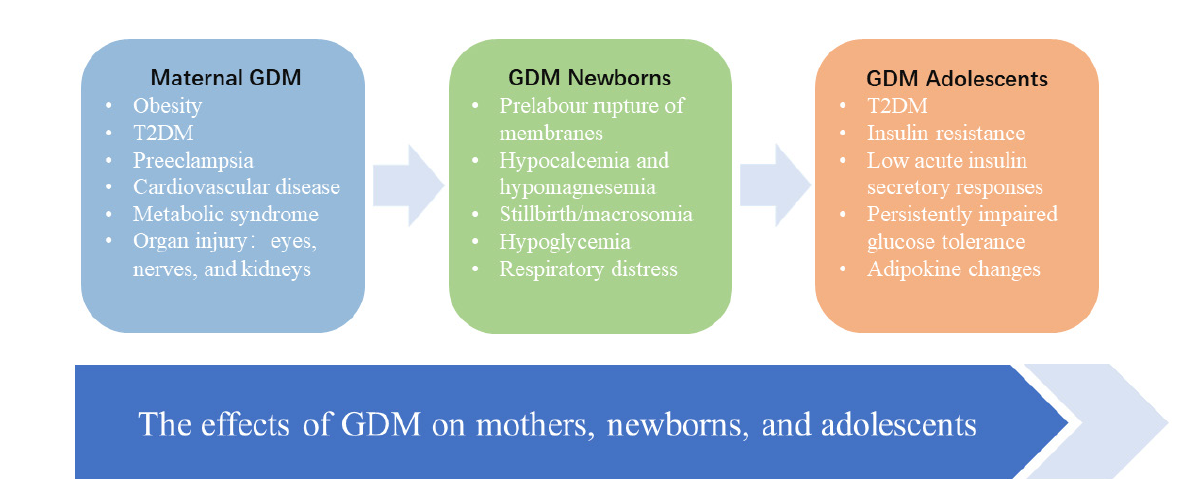
Figure 1. A variety of effects on both GDM mothers and offspring. In addition to maternal target organ damages, GDM can lead to obstetric accidents in newborns and metabolic dysfunction in adolescents. The adverse health effects of GDM in various groups are listed